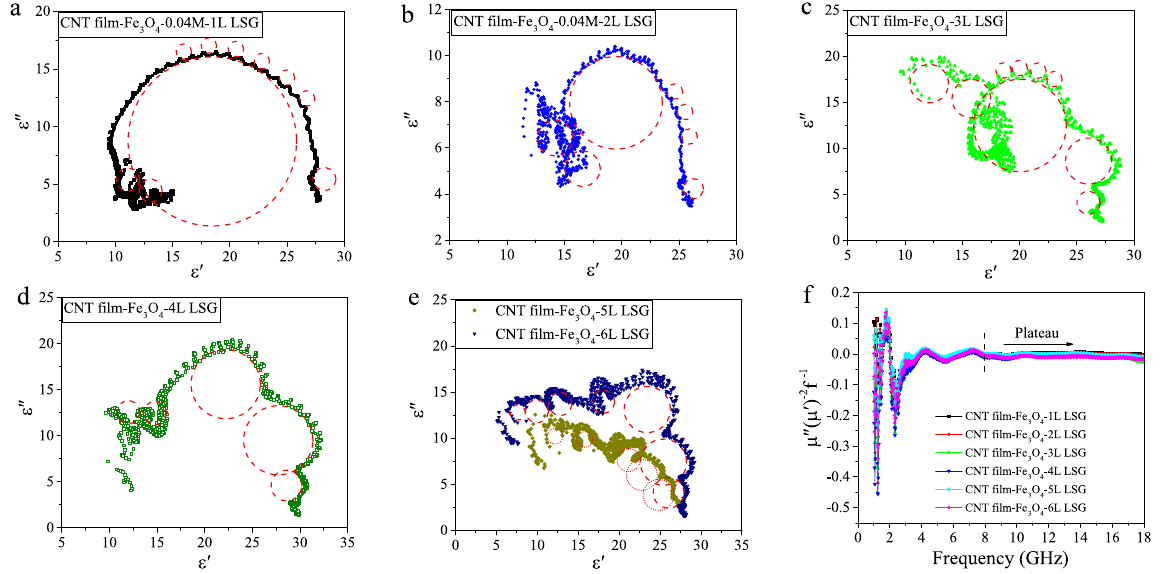
Figure 6. Dielectric Cole-Cole semicircles of the CNT film-Fe 3 O 4 -0.04 M-LSG composites: ( a ) one, ( b ) two, ( c ) three, ( d ) four, ( e ) five and ( f ) six layers of graphene, respectively. ( f ) μ″ ( μ′ ) − 2 f − 1 vs. frequency f for the CNT film-Fe 3 O 4 -0.04 M-LSG composites.